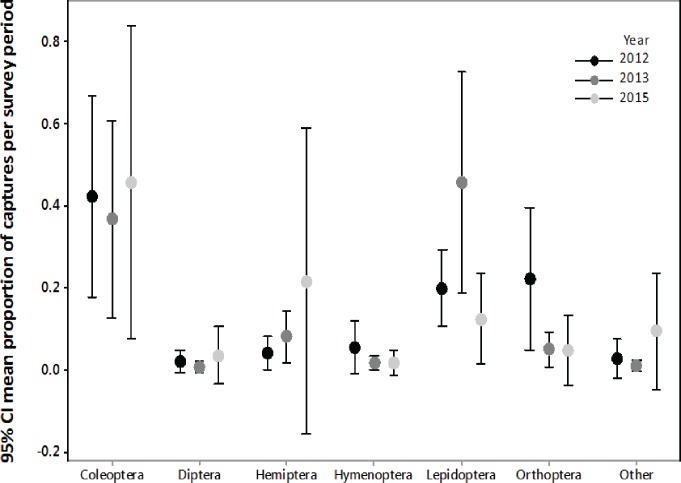
Biweekly proportions of insect orders surveyed at turbine towers.Biweekly averages and 95% CI of the proportions of each order collected during July–August light trapping in 2012, 2013, and 2015 at the Wolf Ridge wind farm. The “other” category includes Blattodea, Ephemeroptera, Neuroptera, Odonata, Plecoptera, Trichoptera, and spiders.